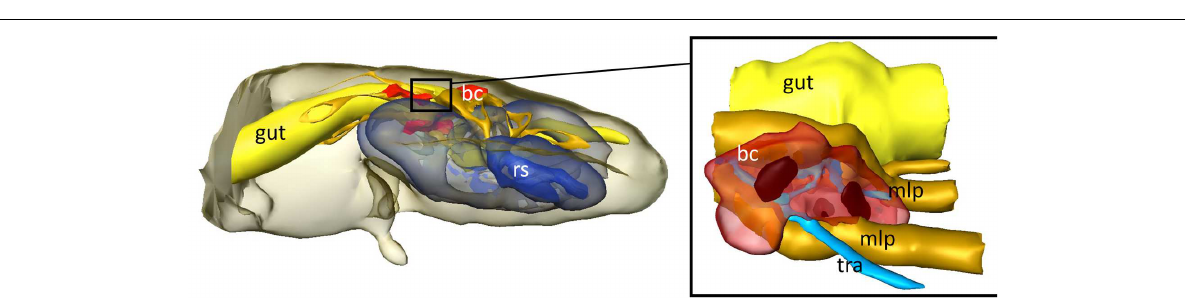
FIGURE 4 | 3D-reconstruction of the interior organs in the abdomen of D. plumbeus . mlp, Malpighian tubules; bc, bacteriocytes; tra, tracheae; rs, reproductive